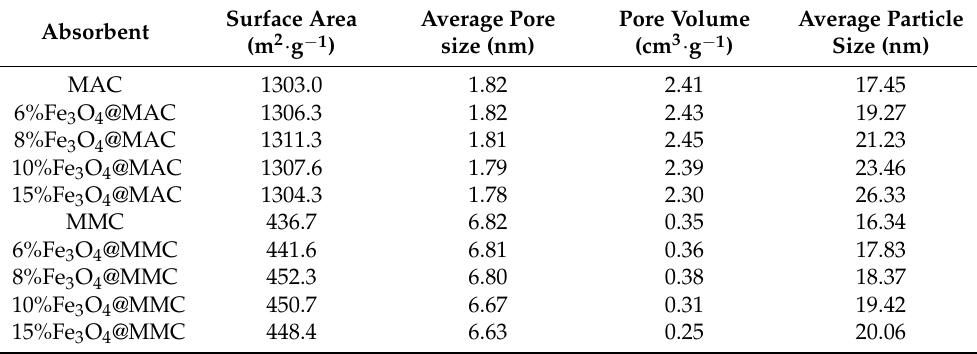
Figure 4. X-ray diffraction (XRD) patterns of 8%Fe 3 O 4 @MAC adsorbent: ( a ) fresh and ( b ) after adsorption. Table 3. Textural properties of some